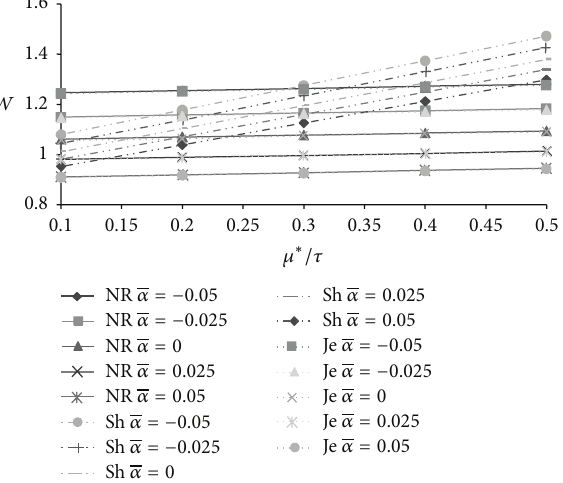
Figure 5: Variation of load carrying capacity with respect to 𝜇 ∗ /𝜏 and 𝛼